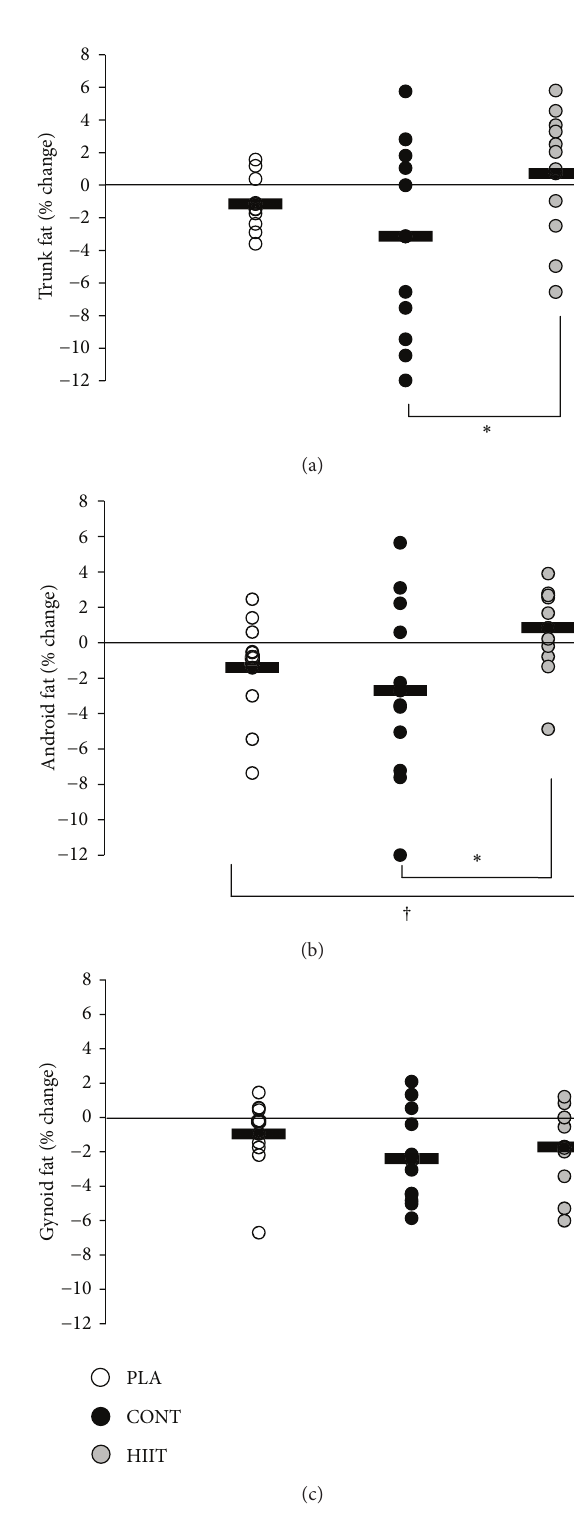
Figure3:Effectof12weeksofhighintensityintervaltraining(HIIT) or continuous aerobic exercise (CONT) or control (PLA) on relative percent change in (a) trunk fat, (b) android fat, and (c) gynoid fat. Circles show individual percentage change from baseline and horizontal bars show mean group percentage change from baseline. Values are means ± SE; 𝑛 = 13 for HIIT, 𝑛 = 13 for CONT, and 𝑛 = 12 forPLA. † Significanttreatment × timeinteraction( 𝑃 < 0.05 ). ∗ Significant difference between CONT and HIIT ( 𝑃 < 0.05